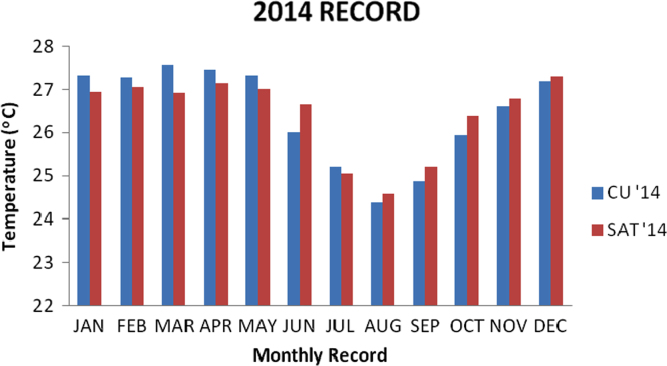
Chart for 2014 data.